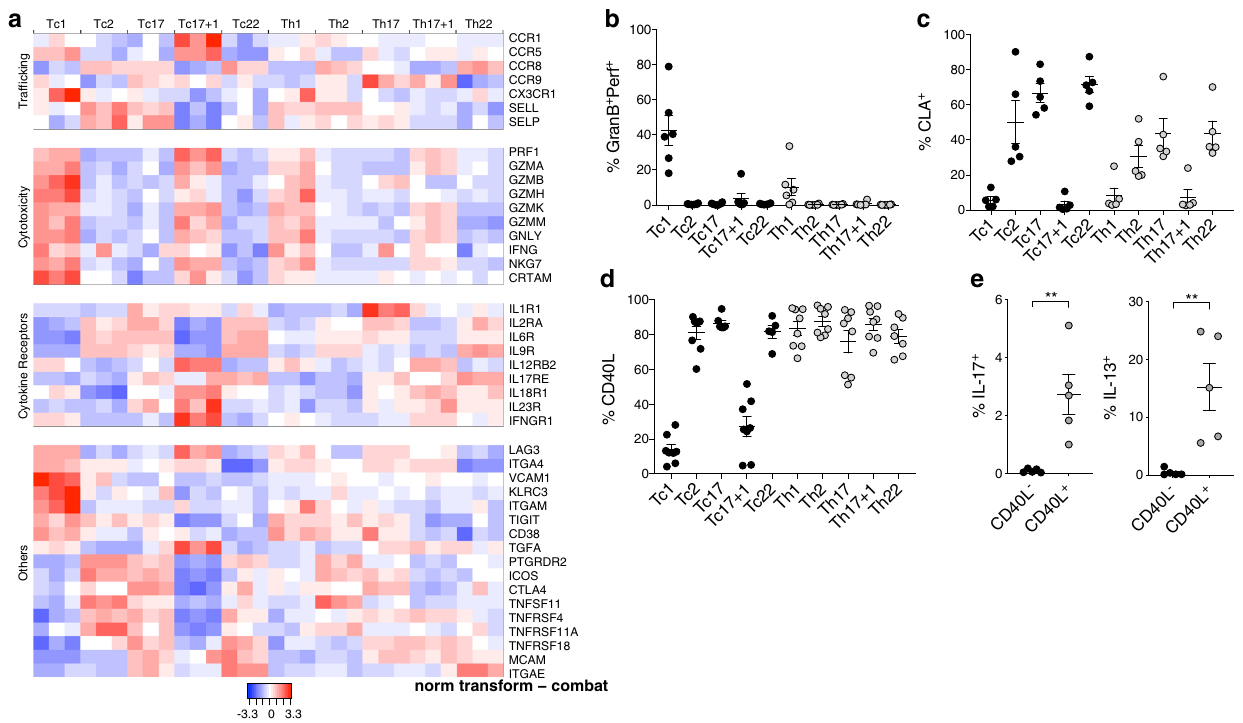
Fig. 3 Tc2, Tc17, and Tc22 CD8 + T-cell subsets possess helper characteristics. a Heatmap representation of normalized, log2-transformed RNA-Seq expression values of selected genes. b , c Perforin and granzyme B ( b ) or CLA ( c )-expressing cells among resting CD45RA − CD8 + (black circles) and CD4 + (gray circles) T-cell subsets ( n = 6), mean ± SEM. d CD40L-expressing cells among sorted and polyclonally activated Tc- (black circles) and Th- (gray cicrcles) cell subsets ( n = 8), mean ± SEM. e Frequencies of IL-17 + and IL-13 + cells among splenocyte derived CD40L − (black circles) or CD40L + (gray circles) dump − CD3 + CD44 + CD8 + memory T cells from pet shop mice after polyclonal activation. Mean± SEM. Student ’ s t test. * P < 0.05, ** P < 0.01, *** P <